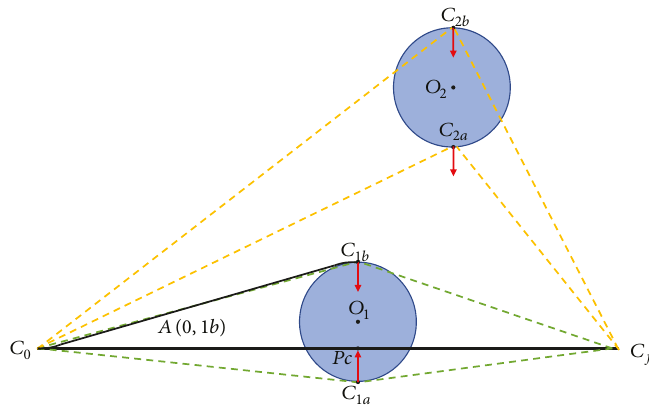
Figure 4: The implementation example of the HTE strategy in static collision situation.